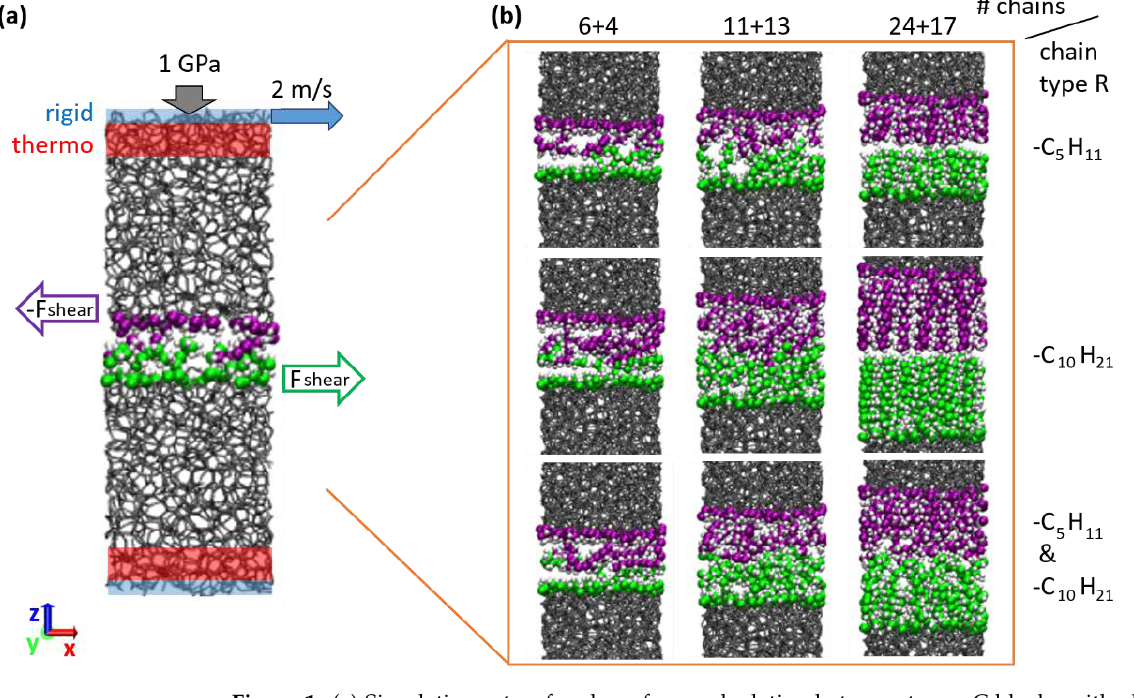
Figure 1. ( a ) Simulation setup for shear force calculation between two a-C blocks with alkane or alcohol chains chemisorbed on the surfaces in contact (gray sticks: bulk C-C bonds; spheres: surface atoms, white spheres represent H, green and violet spheres are C atoms of lower and upper surface, respectively). Blue shaded areas are rigid layers used to impose the normal load and the sliding velocity. The regions (red) adjacent to the rigid layers are coupled to a Langevin thermostat with a target temperature of 300 K. Further details are described in Materials and Methods. ( b ) Snapshots of the interface regions after sliding for all considered alkane chain terminations on the a-C with the highest density. Rows: different chain lengths (top to bottom: pentane; decane; mixture of both). Columns: different number (#) of grafted chains (increasing from left to